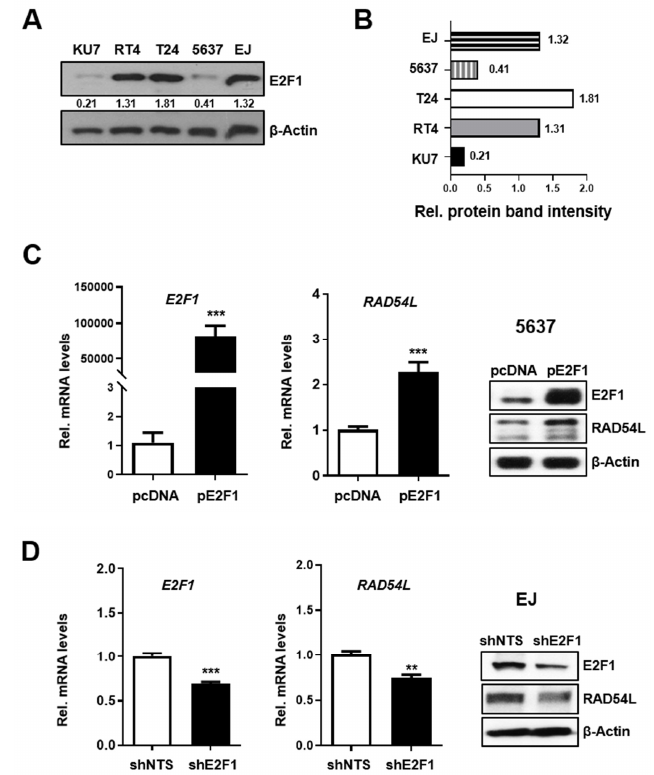
Figure 2. E2F1 regulates RAD54L gene expression. ( A ) E2F1 protein expression levels and ( B ) protein band intensities in BLC cell lines including KU7, RT4, T24, 5637 and EJ cell lines were detected by western blotting analysis. The mRNA and protein levels of E2F1, RAD54L in ( C ) E2F1-transfected 5637 cells, and in ( D ) EJ cells (shE2F1, control cells; shNTS) with a stable E2F1 knockdown were analyzed by qRT-PCR and western blot. Data are presented as mean ± SD. **, P < 0.01; ***, P <